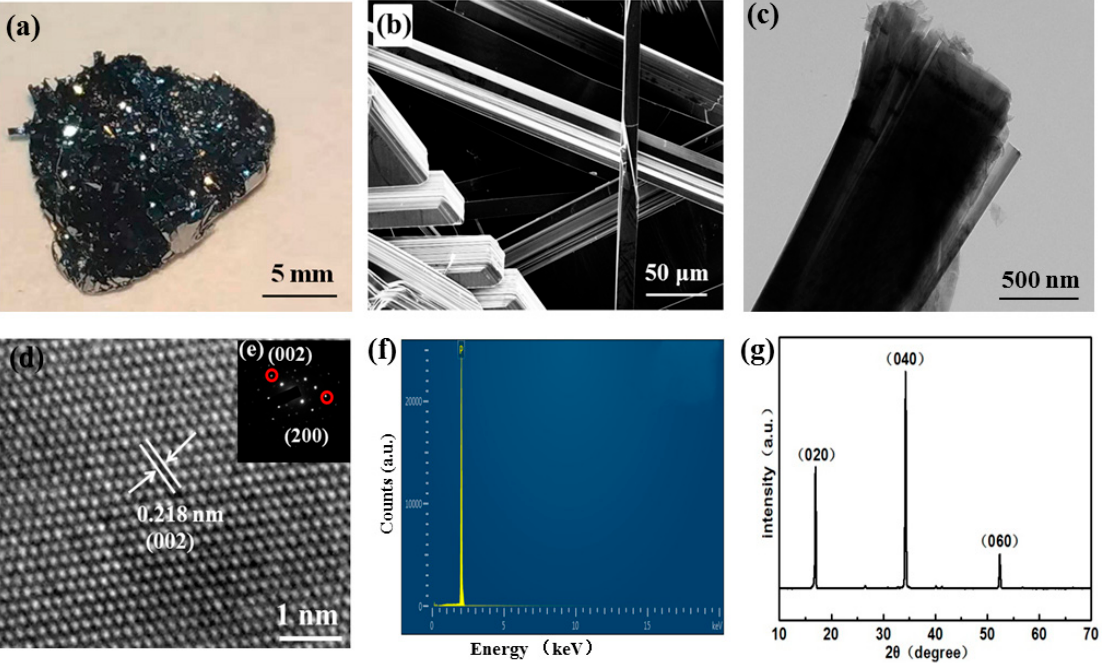
Figure 1. Structure and properties of black phosphorus (BP) crystals grown by the mineralization method: ( a ) photograph of a 1.5 cm BP single crystal; ( b ) SEM image and ( c ) low-magnification and ( d ) high-resolution TEM images of the BP crystal; and ( e ) selected area electron diffraction (SAED) pattern, ( f ) EDS spectrum, and ( g ) XRD pattern of the BP single crystal.